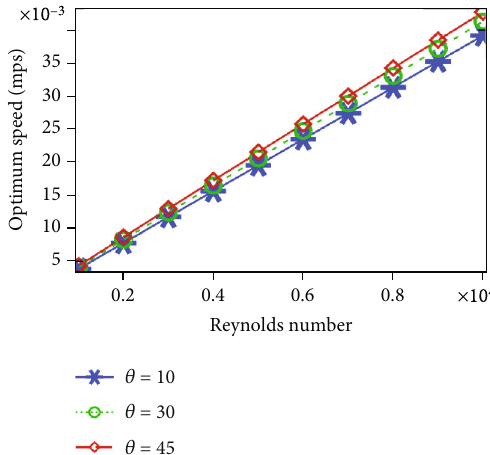
Figure 6: The optimum speed is the linear function of the Reynolds number.